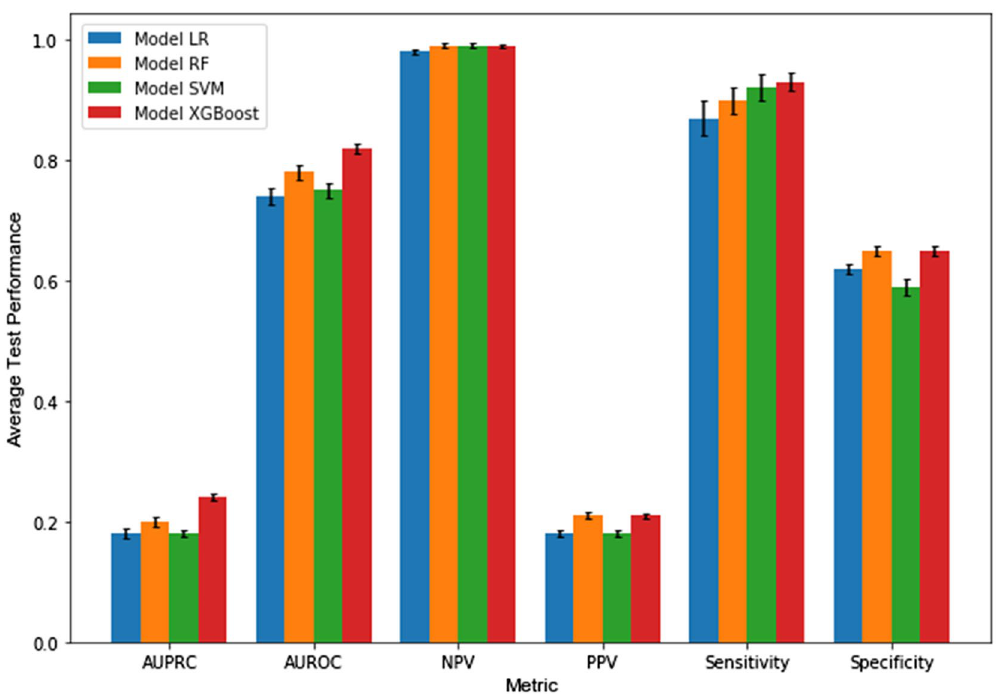
Figure 3. Performance of each modeling approach for predicting elevated ICP events with a 30 min prediction horizon. Error bars = 95% confidence